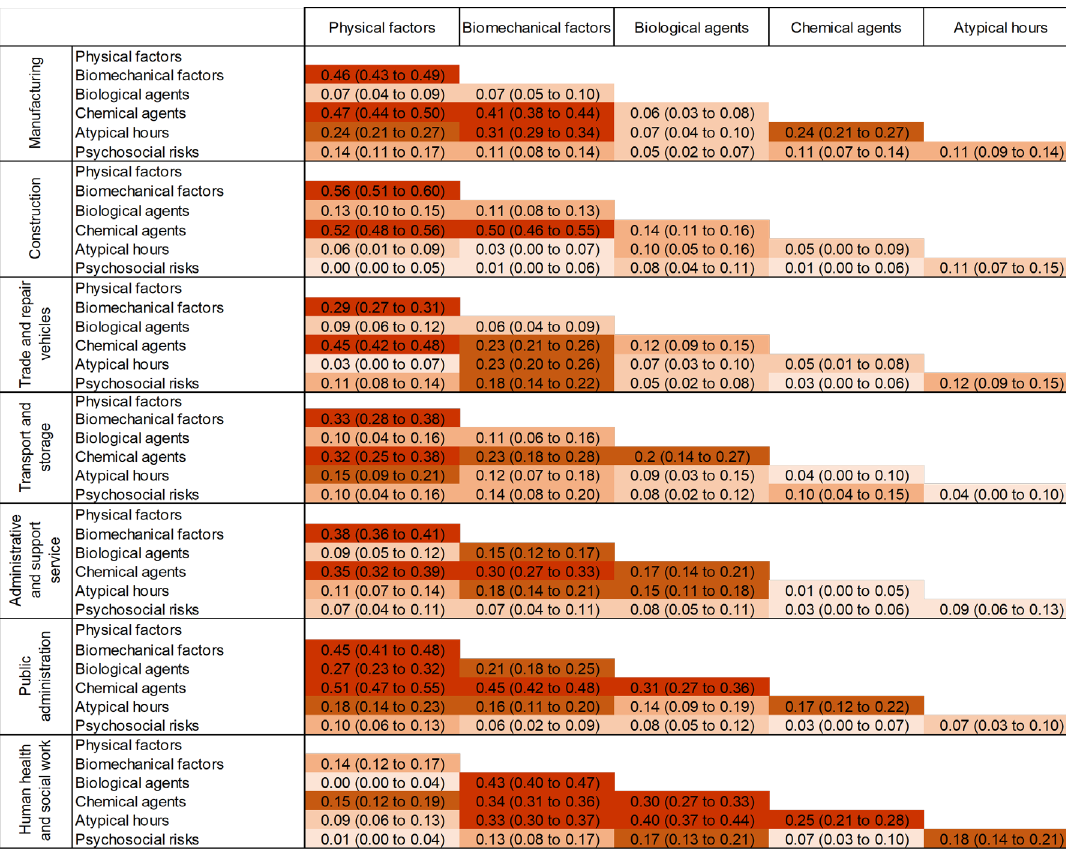
Figure 3. Heatmap of Cramer’s V (i.e., effect size (ES)): risk by sector.